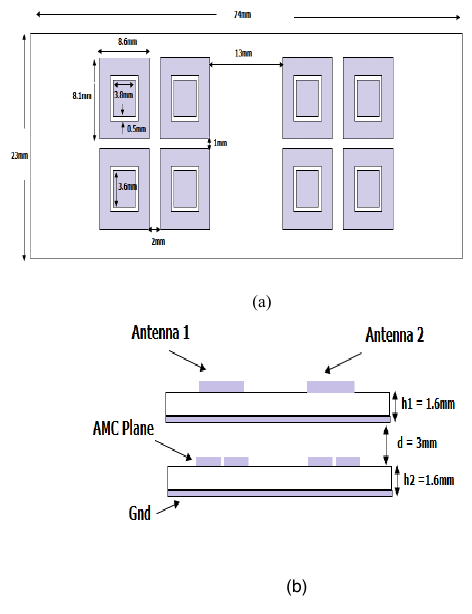
FIGURE 2. (a) AMC dimensions (b) Cross-section view of the proposed antenna with